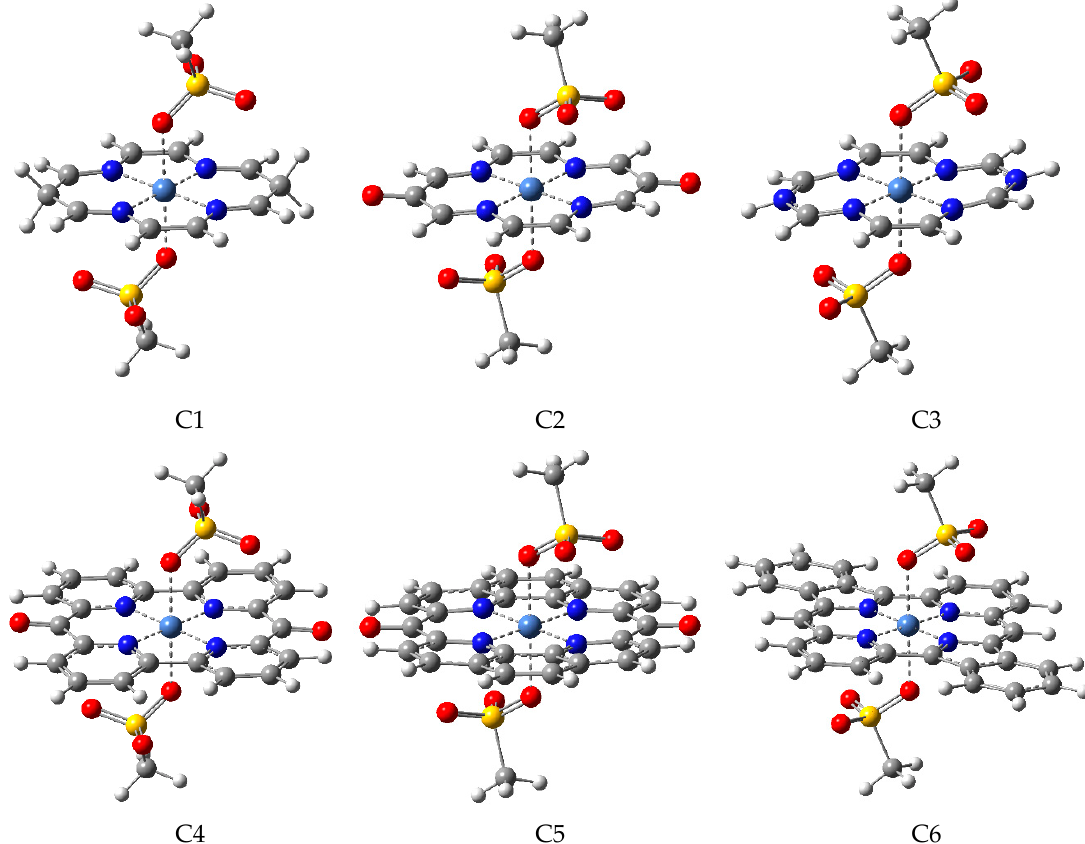
Figure 3. The equilibrium geometry configuration of the six proposed metal-organic complexes (C1–C6) with triplet spin configuration.